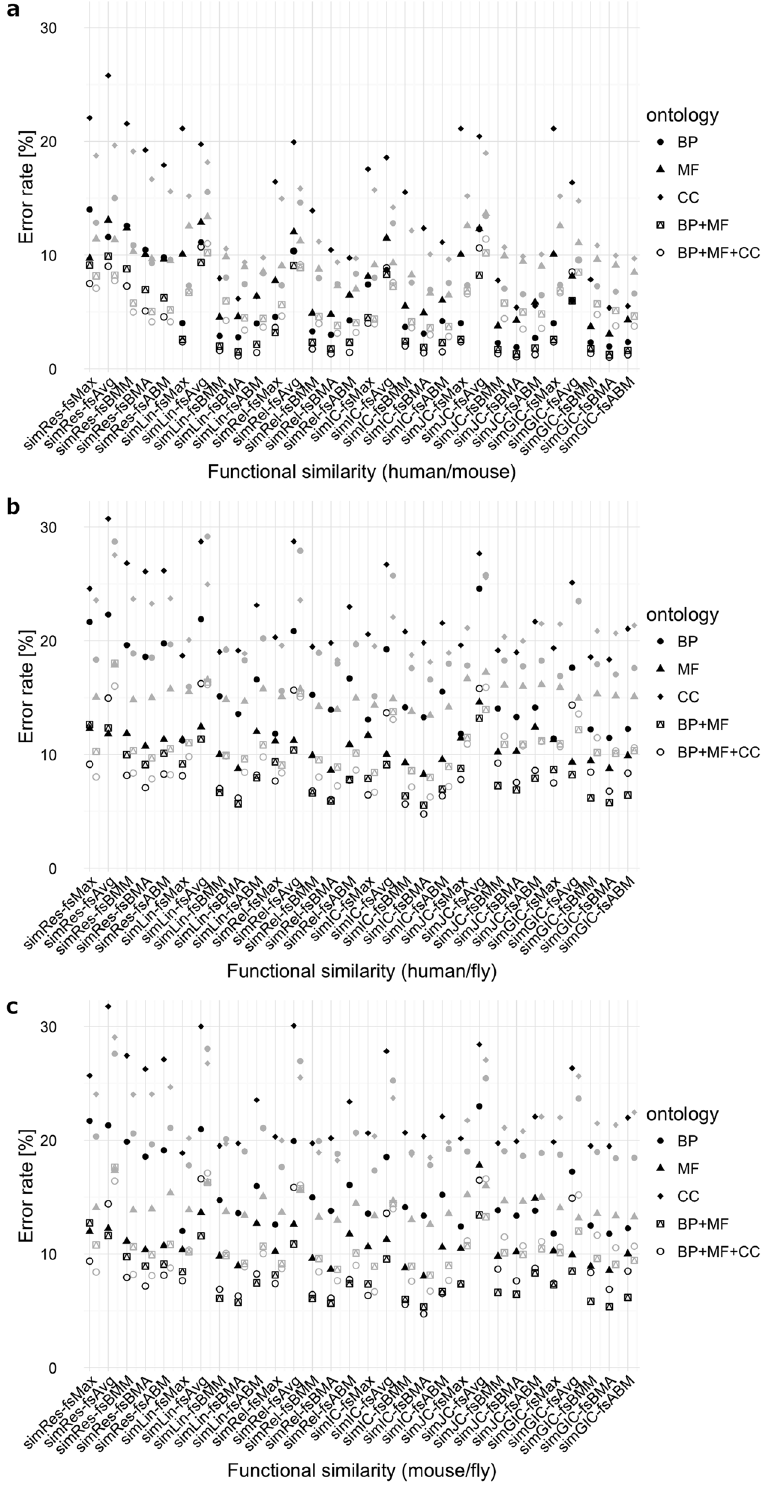
Figure 3. Error rates of various FS measures computed for different ontologies. Each panel shows error rates for different measures ( x -axis, measure names separated by a hyphen) for all three gene ontologies and the two combined ontologies (encoded by symbols, see legend to the right of each panel). Error rates for IEA ( + ) dataset- derived scores are shown in black, and the corresponding scores calculated for the IEA ( − ) dataset are depicted as grey symbols in a separate column to the right of the corresponding IEA ( + ) results. Since the error rates are given as percentages, we refer to Table 2 for dataset sizes and Supplementary Data File S1 for underlying raw data. Panels represent all orthology relationships that entered this study: ( a ) human/mouse orthologues; ( b ) human/fly orthologues; and ( c ) mouse/fly